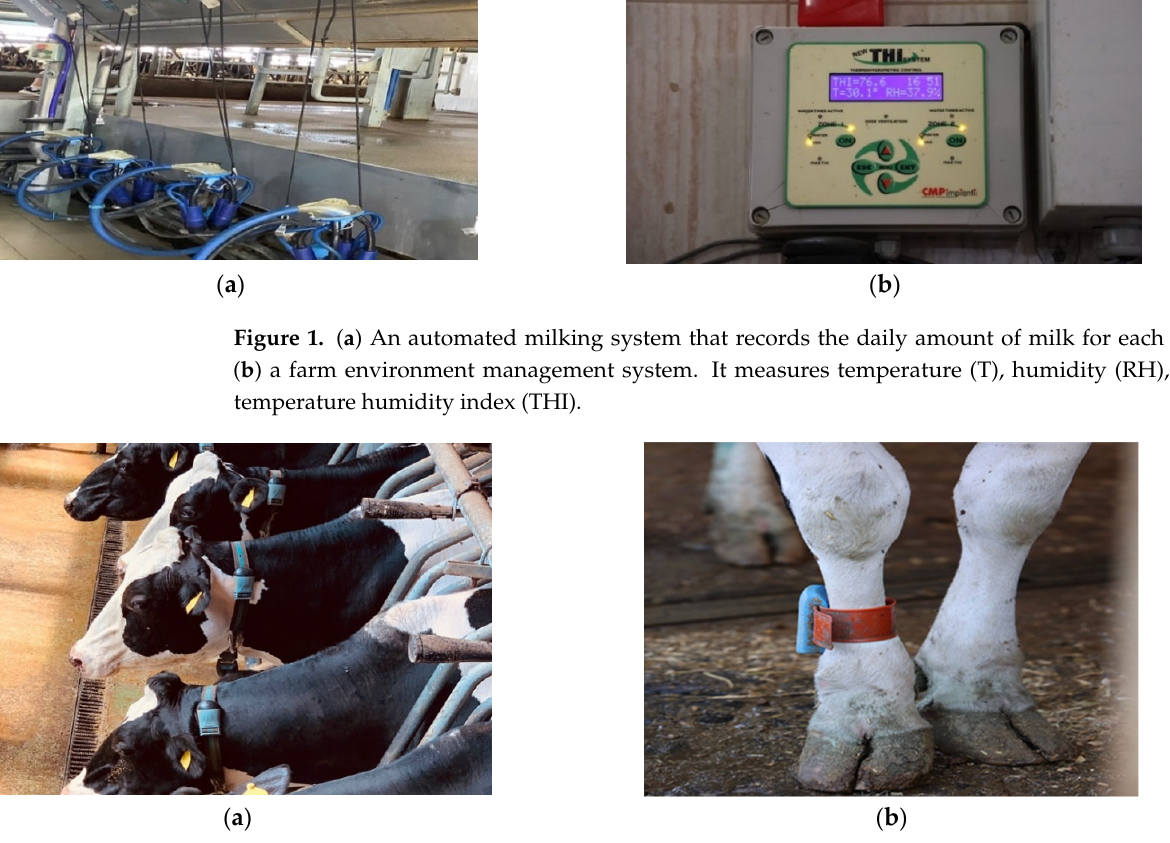
Figure 2. ( a ) Cow neck device with sensors for movement and ( b ) cow leg device with sensors for heat detection, animal identification, and calving alert.